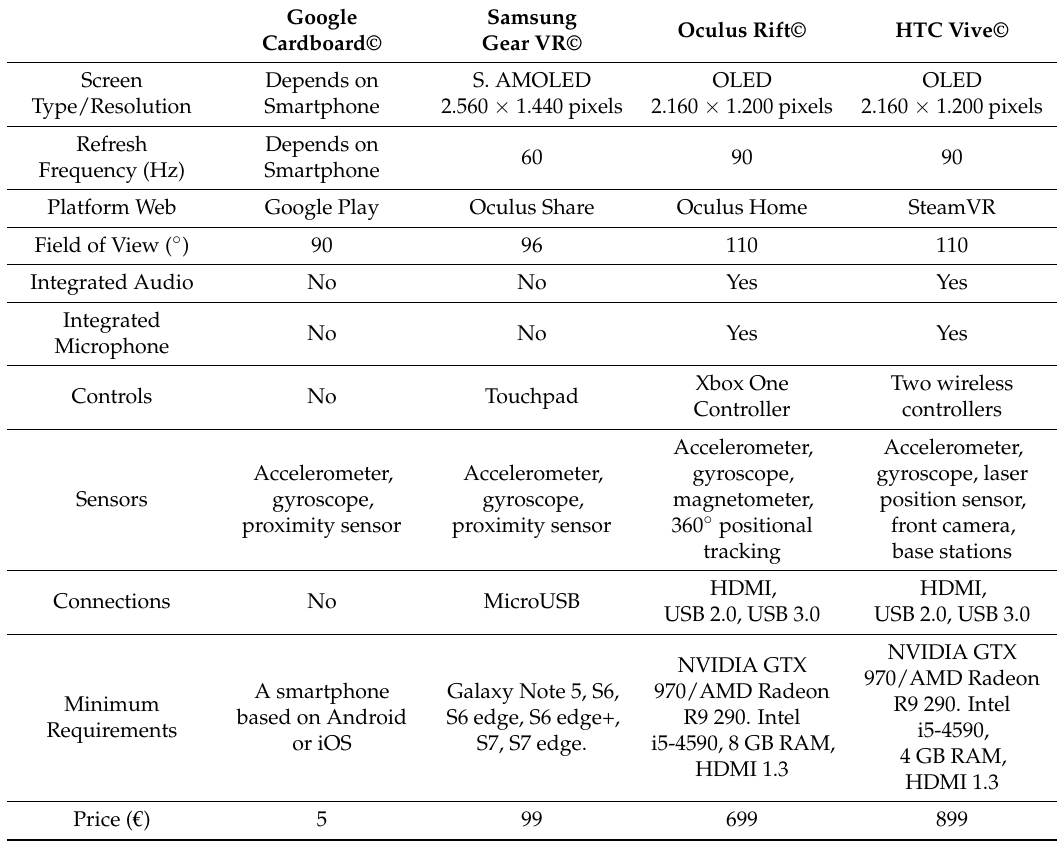
Table 1. Main features of the current commercial VR